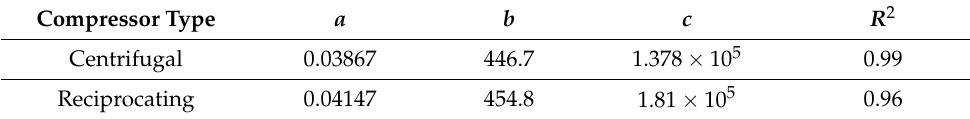
Table 2. The coefficients of Equation (2) for both compressor types.